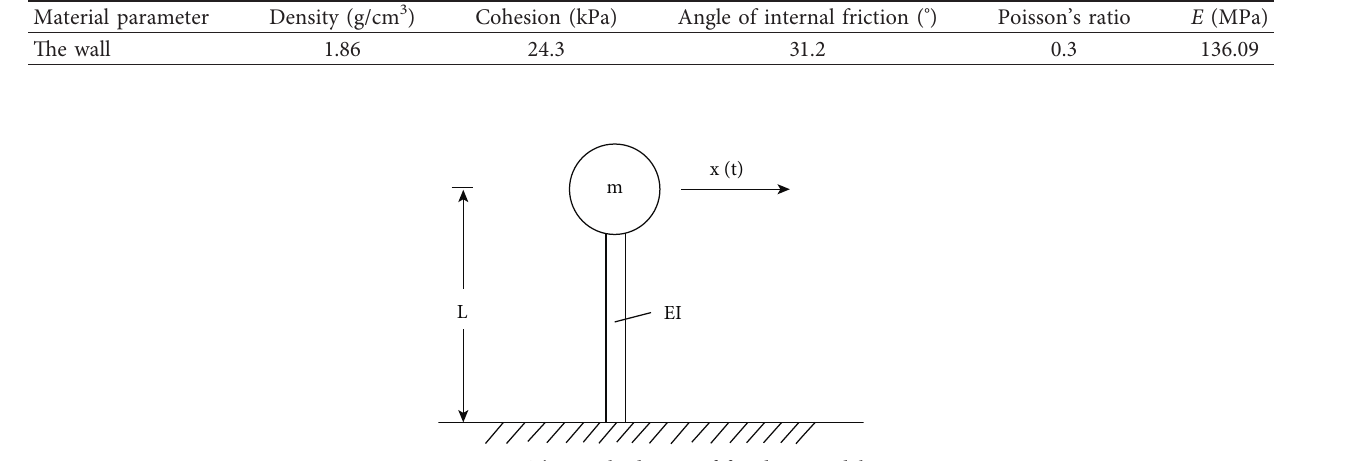
Figure 7: The single-degree-of-freedom